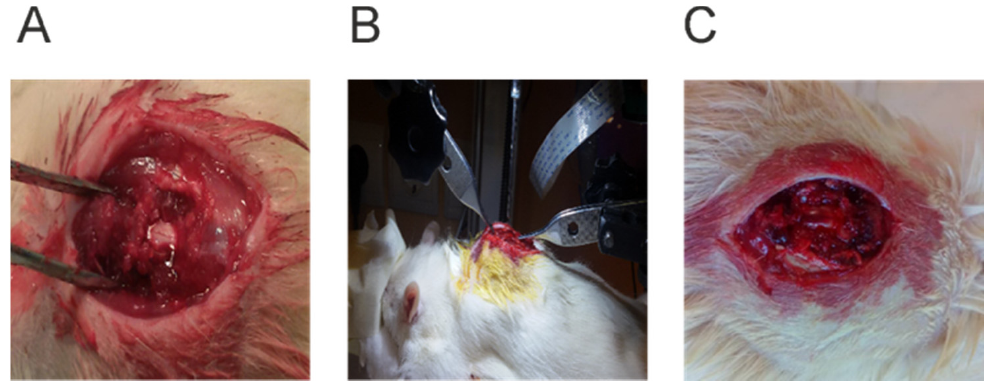
Figure 1. ( A ) Laminectomy of the spinal cord, ( B ) using the Horizons Impactor device, ( C ) after spinal cord injury and the formation of a hematoma.